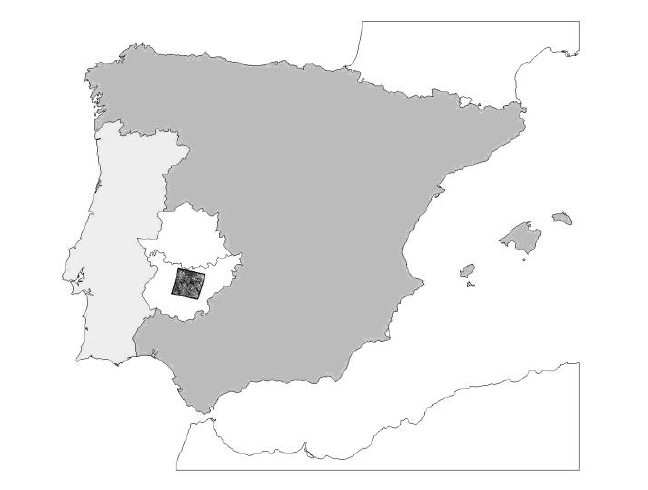
Figure 1. Location of the Extremadura test area in southeastern